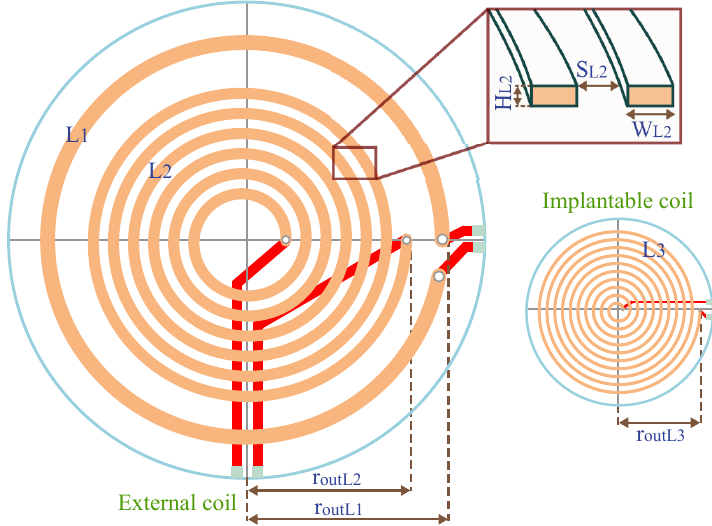
Figure 6. Proposed geometry coil